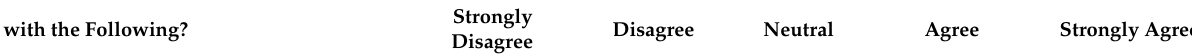
Table A1. The content of brief